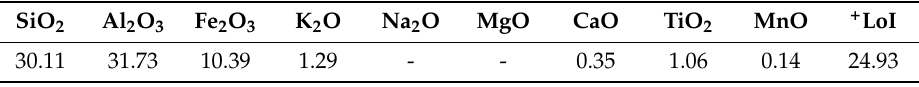
Table 3. Chemical composition of the MWS sample (wt.